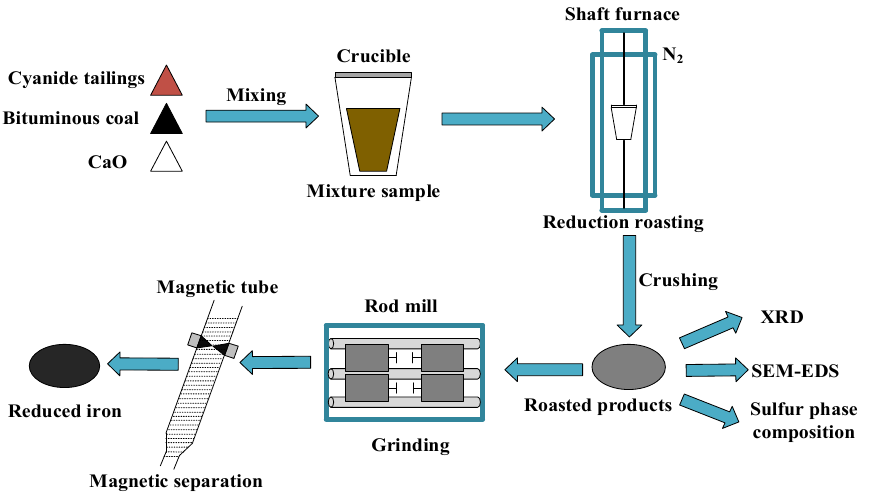
Figure 2. Experimental procedure for reduction roasting-magnetic separation process of cyanide tailings.